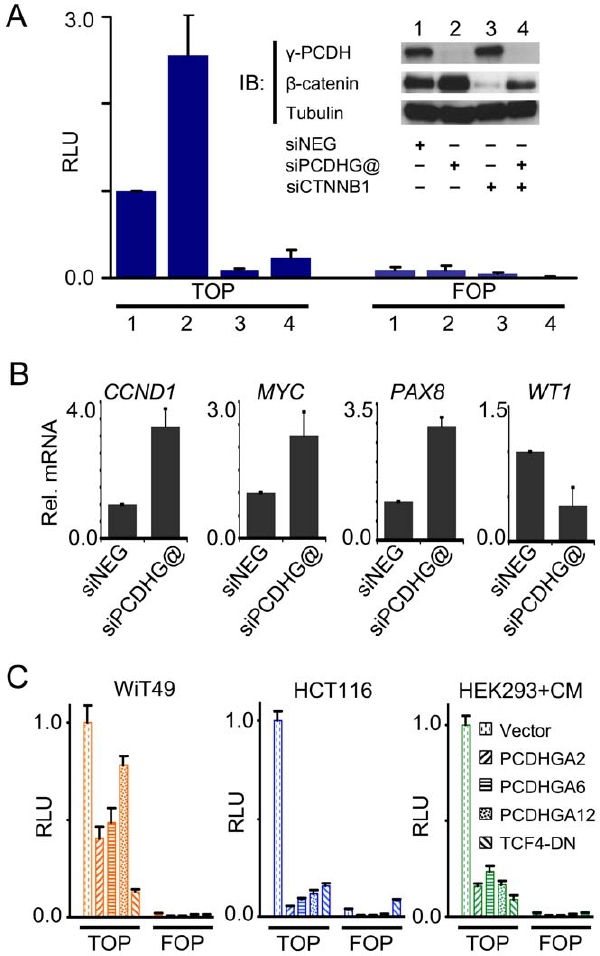
Figure 5. PCDH effects on Wnt signalling. (A) Enhanced b -catenin/ TCF activity following c -PCDH knockdown induced by PCDHG@ constant region targeting siRNA, measured with Super8xTOPFLASH reporter (TOP). Super8xFOPFLASH (FOP) reporter is a negative control. RLU, relative luciferase units. Gamma-PCDH and b -catenin knockdowns are verified by immunoblotting (IB) in the inset, which also demonstrates increased cellular b -catenin accompanying c -PCDH knockdown. (B) Quantitative real-time expression analysis, relative to TBP , showing induction of the Wnt pathway target genes CCND1 , CMYC , and PAX8 accompanying c -PCDH knockdown; altered expression of conditioned medium treated HEK293 (HEK293 + CM) cells. A plasmid containing a cDNA encoding dominant-negative TCF4 (TCF4-DN) is also shown as a positive control. Cells were co-transfected with PCDH expression vectors and Super8xTOPFLASH (TOP) or Super8xFOPFLASH (FOP) and luciferase activity measured. RLU, relative luciferase units.